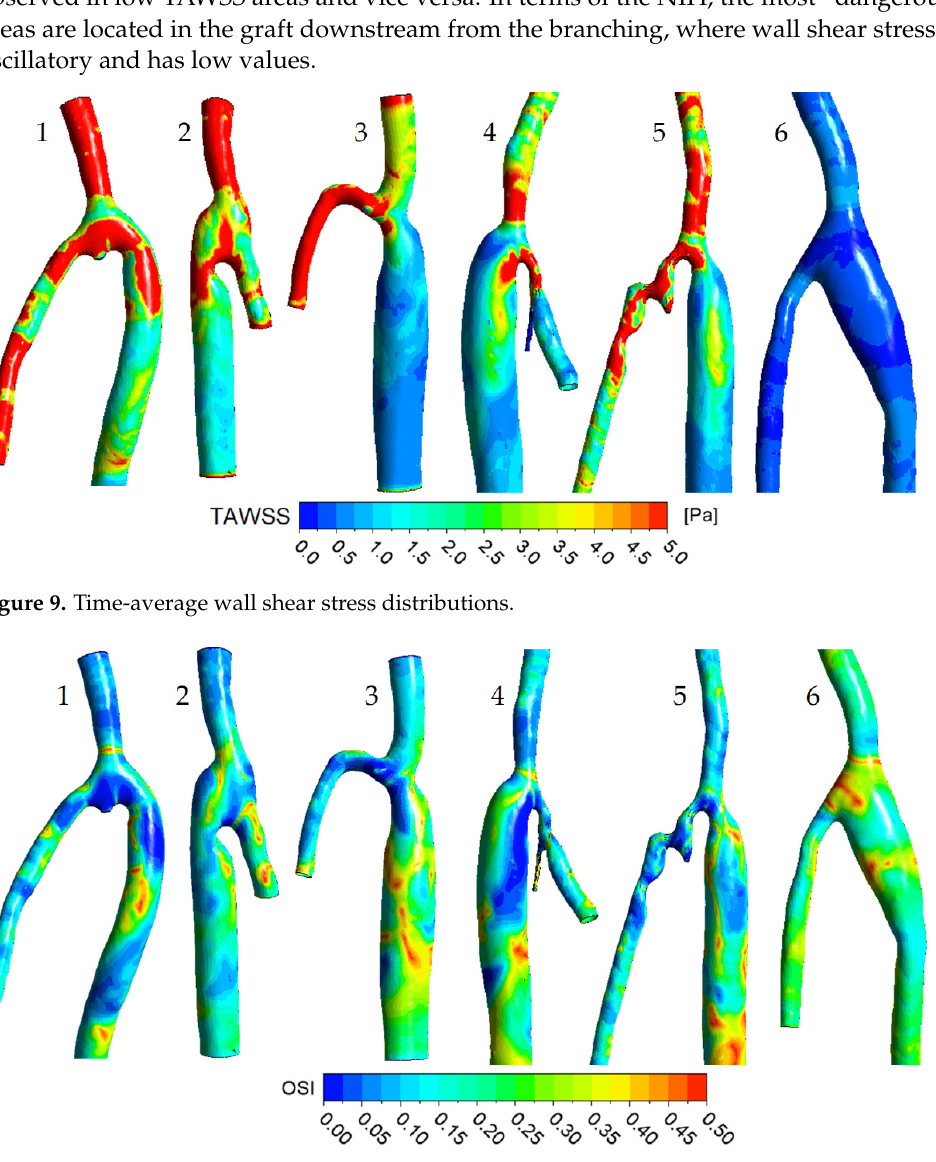
Figure 10. Oscillatory shear index distributions.